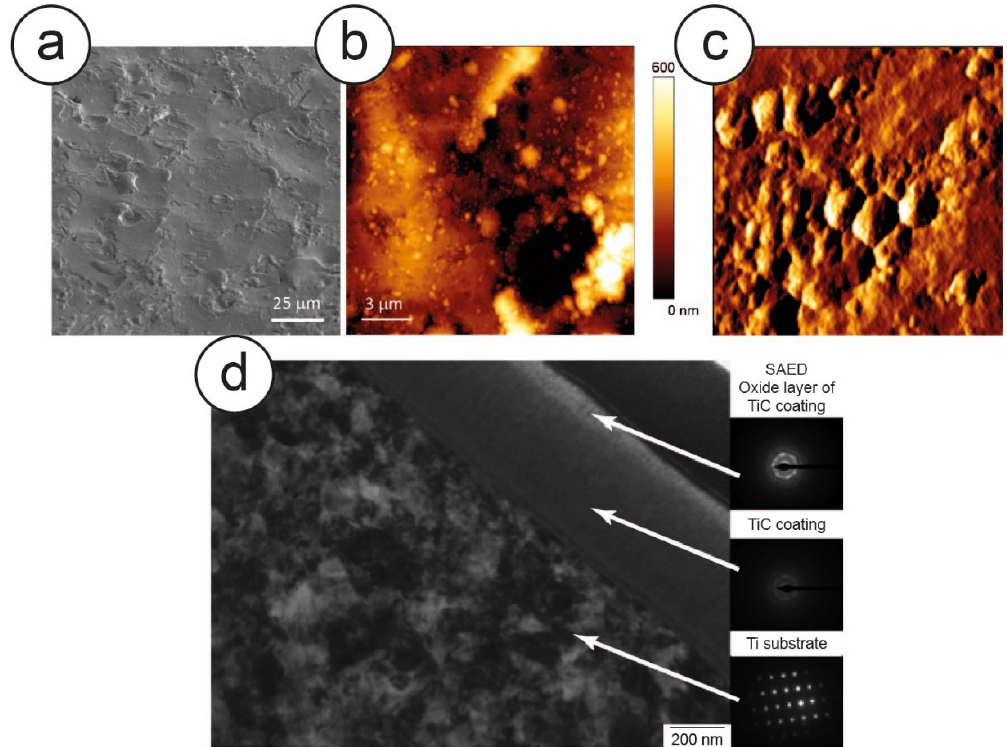
Figure 4. A collection of morphological images of the nanostructured TiC surface layer in a 900 W sample. ( a ) Scanning Electron Microscopy (SEM) image. ( b ) Large-scale topography and ( c ) high-resolution error signal Atomic Force Microscopy (AFM) images. ( d ) Analysis with Focused Ion Beam (FIB) / Transmission Electron Microscope (TEM)-Selected Area Electron Di ff ractometer (SAED) to determine the di ff